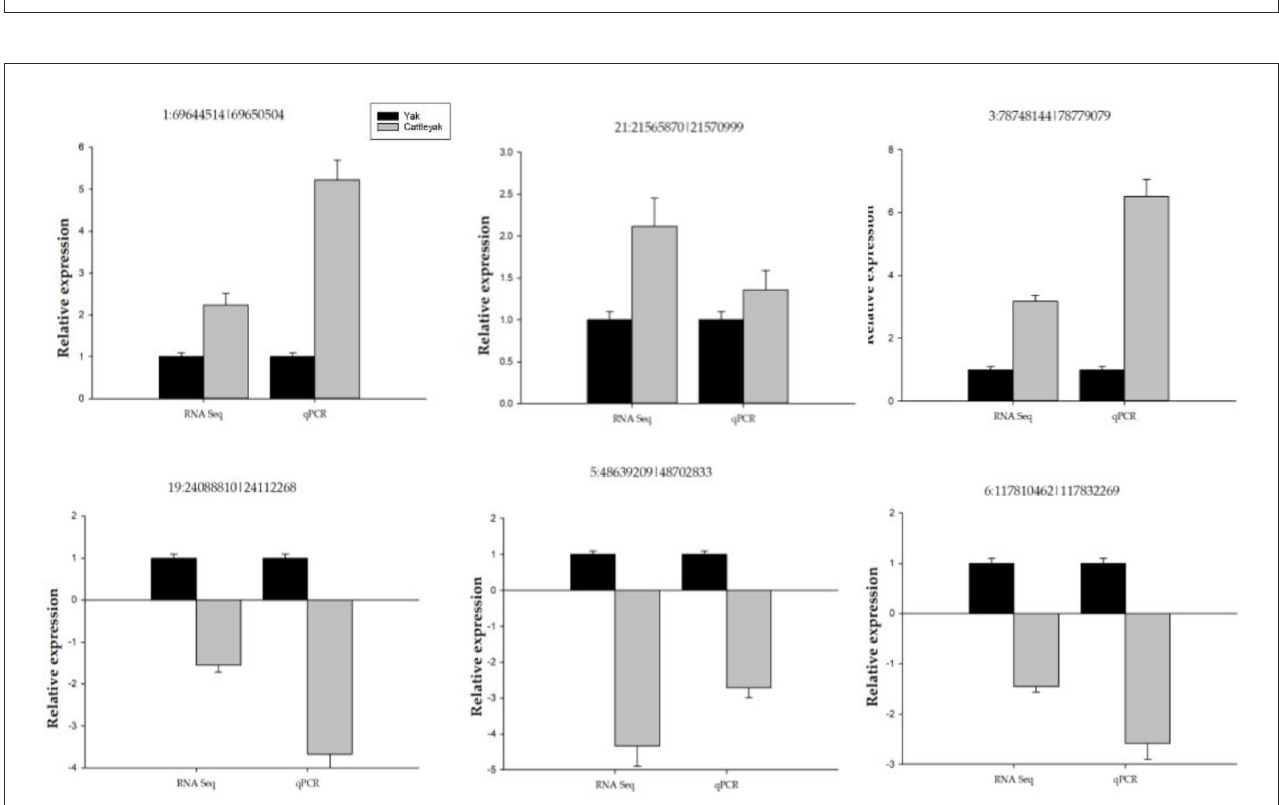
FIGURE9 CircRNA origin gene Cluster of Orthologous Groups of proteins (COG) annotation classification statistical map. The abscissa is the classification content of COG, and the ordinate is the number of genes.